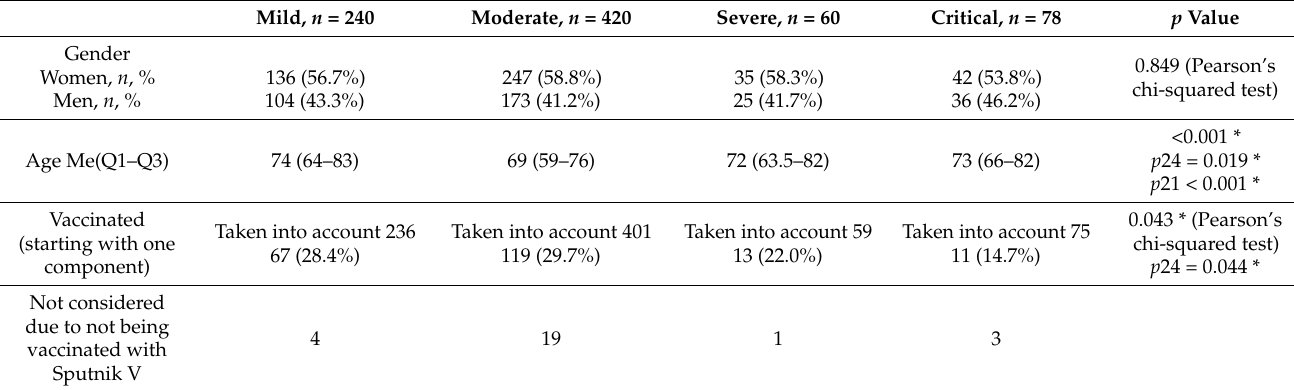
Table 1. Demographic analysis of patients (gender, age, and severity are known; n =